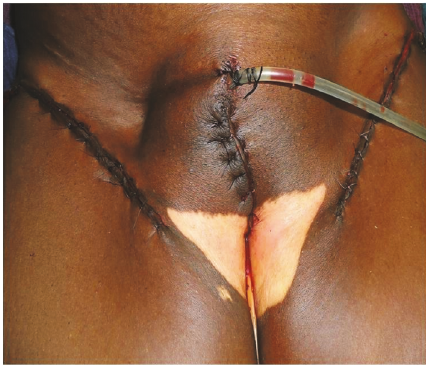
Figure 5: After wound closure.